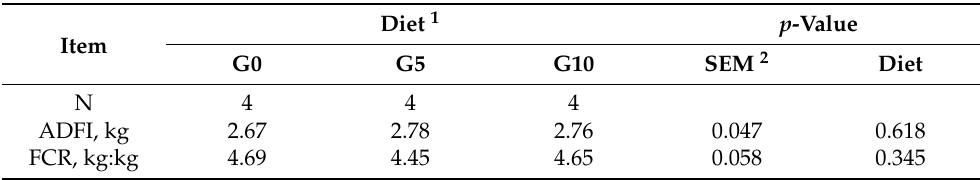
Table 3. Effects of glycerin addition to feed on average daily feed intake and feed conversion ratio of Iberian crossbred pigs.